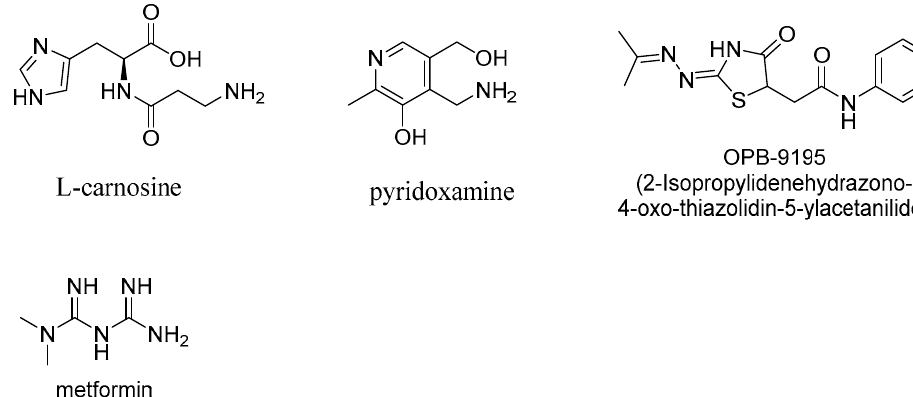
Figure 8. Structures of AGE-inhibitor compounds L-carnosine, pyridoxamine, and